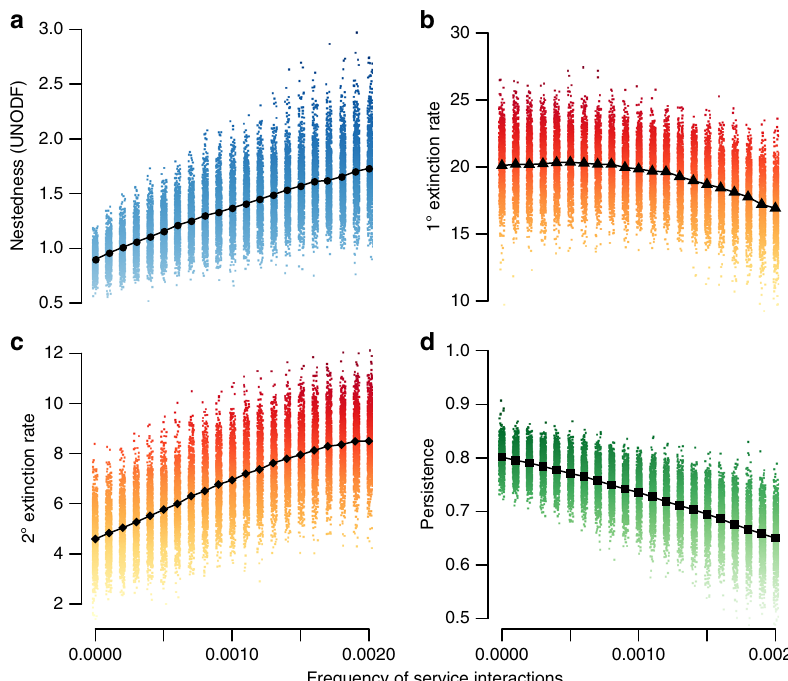
Fig. 3 Community structure and stability as a function of the frequency of service interactions. a Structural nestedness of communities, measured as UNODF (Unipartite Nestedness based on Overlap and Decreasing Fill; measured using the R package UNODF v.1.2) 100 . The value reported is the mean value taken across the rows and columns of the adjacency matrix accounting for both trophic and service interactions. b Mean rate of primary extinction (where primary extinctions occur from competitive exclusion of consumers over shared resources) and c secondary extinction (which cascade from primary extinctions) as a function of service interaction frequency. d Species persistence as a function of service interaction frequency. Primary and secondary extinction rates were evaluated at the community level, whereas persistence was determined for each species and averaged across the community. Measures were evaluated for 10 4 replicates; see “ Methods ” and Supplementary Note 2 for parameter